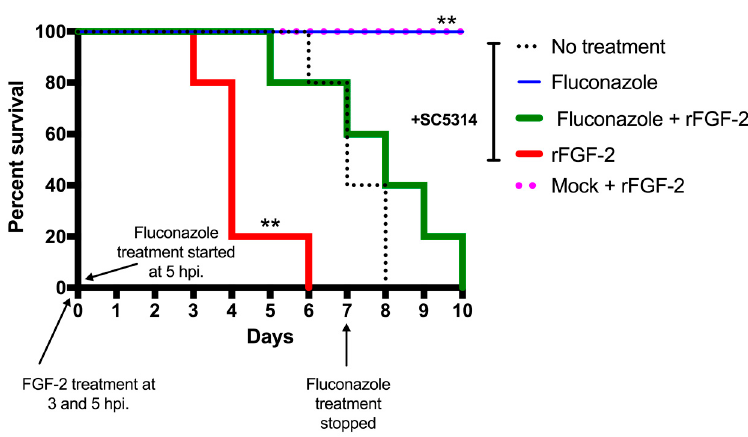
Figure 4. Treatment with FGF-2 increases the mortality rate in a murine model of systemic candidiasis. Balb/C mice were challenged with 1 × 10 6 SC5314 yeast cells via a tail vein. Fluconazole (0.5 mg/kg) was administered daily via the intraperitoneal (IP) route from the day of infection for 7 days in the respective animal groups. Recombinant FGF-2 (1.6 µ g each dose/mouse) was administered intravenously in the respective groups (infected and uninfected) 3 h and 5 h post-infection (hpi). A log-rank (Mantel–Cox) test was statistically significant ( p < 0.0001). A pair-wise comparison was also performed to compare the following infected groups: no treatment vs. rFGF-2 (** p = 0.006), no treatment vs. rFGF-2 + Fluconazole ( p = 0.291), and no treatment vs. Fluconazole (** p = 0.002), as indicated on the graph. Once the fluconazole treatment was stopped, the survival rate of the Fluconazole group changed to 80% (with the death of 1 of the mice) on Day 12 post-infection (not shown on graph). Mice injected with only PBS and rFGF-2 maintained a 100% survival